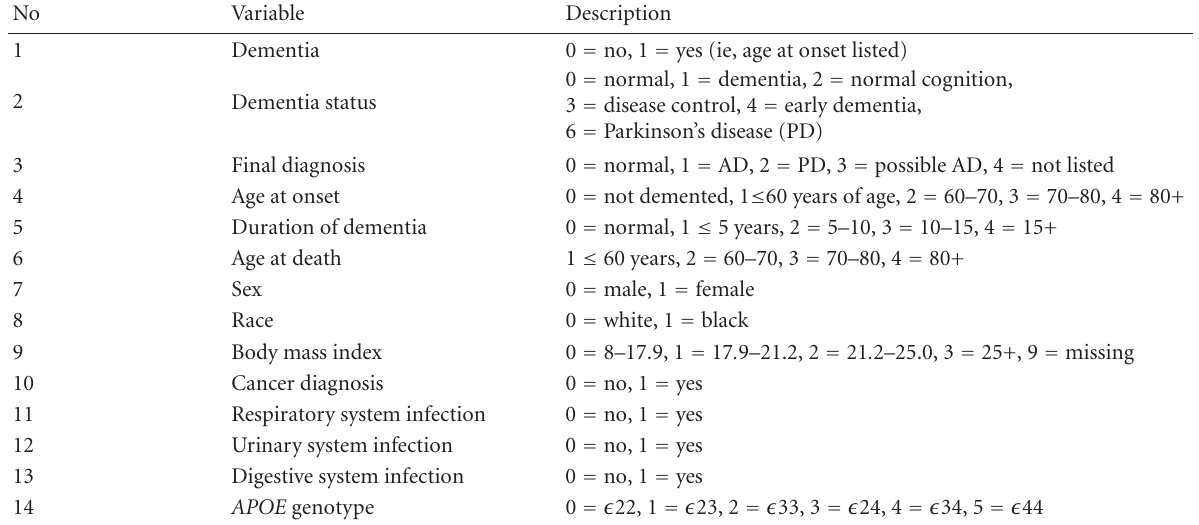
Table 1. The clinical